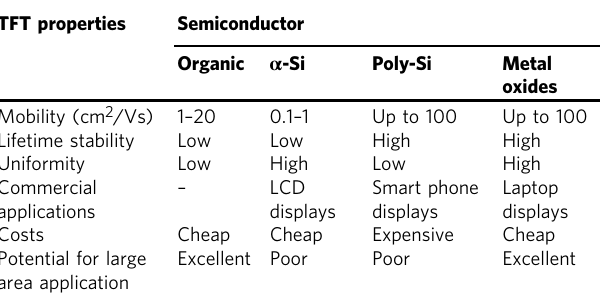
Table 1 Performance and characteristics of TFTs made from different semiconductors